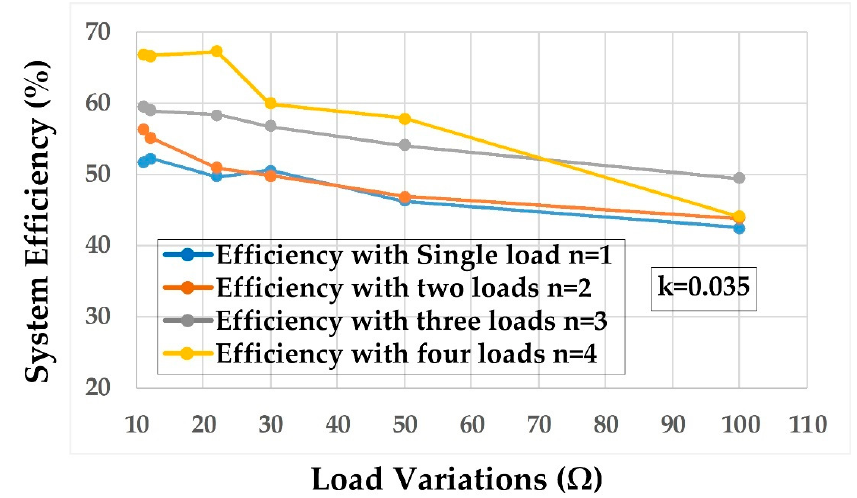
Figure 14. System efficiency against the number of loads.